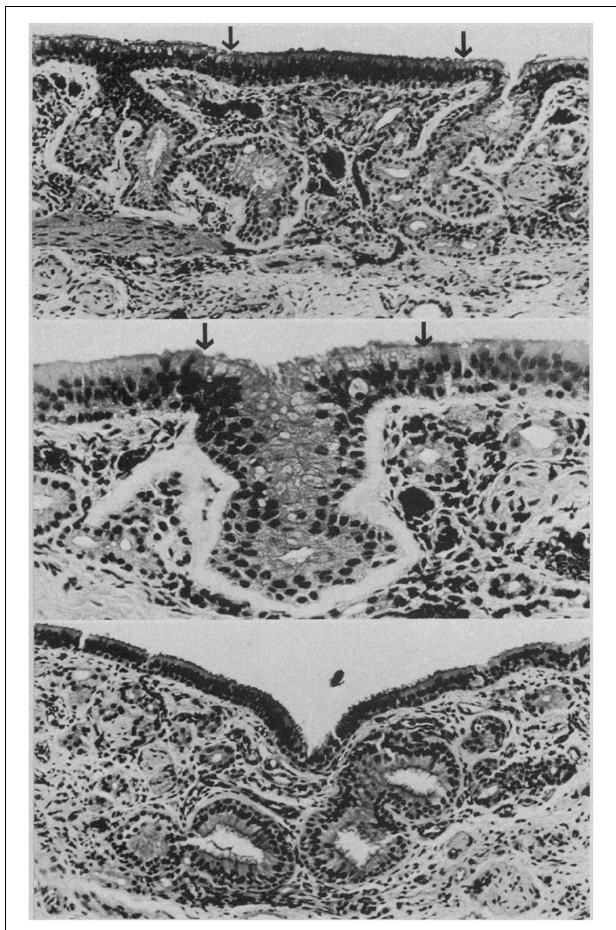
FIGURE 12 | Respiratory epithelium in the olfactory region of the adult human. Top: ciliated and goblet cell-containing respiratory epithelium has invaded degenerated olfactory neuroepithelium (between arrows). Arrows indicate junction of respiratory and olfactory epithelia (HandE, × 100). Middle: gland-like invagination (between arrows) of respiratory epithelium into the lamina propria (HandH, × 200). Bottom: gland-like respiratory epithelium with large lumina in the lamina propria (HandE, × 1000). From Nakashima et al. (1984), with permission. Copyright©1984, American Medical